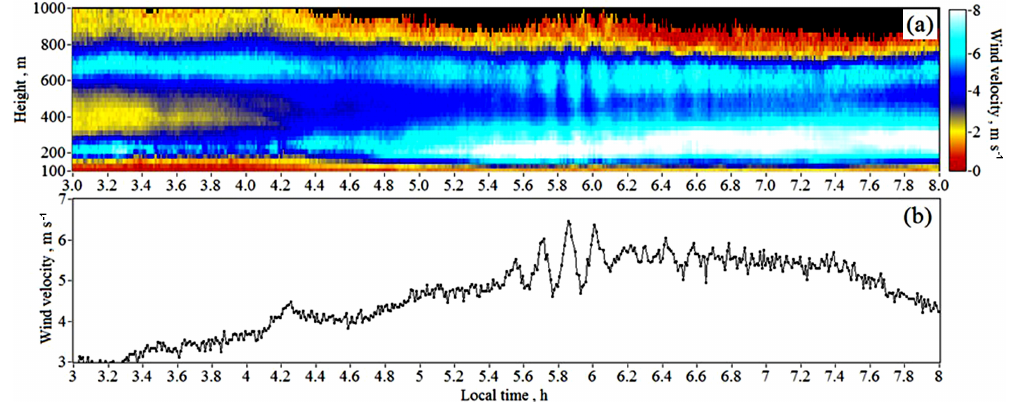
Figure 10. Spatio-temporal distribution of the wind velocity (a) and the time profile of the wind velocity at a height of 532.6ma.g.l. (b) ob- tained from measurements by the Stream Line lidar on 20 August 2015.